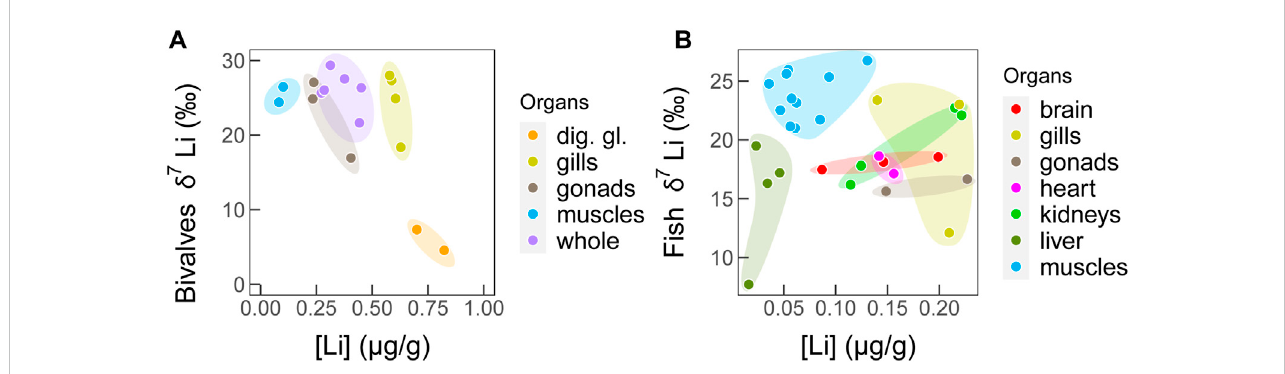
FIGURE 4 Li isotope compositions vs. tissue Li concentration for (A) bivalves, and (B) fi sh tissues from the Bay of Biscay. Colors code for each organ.